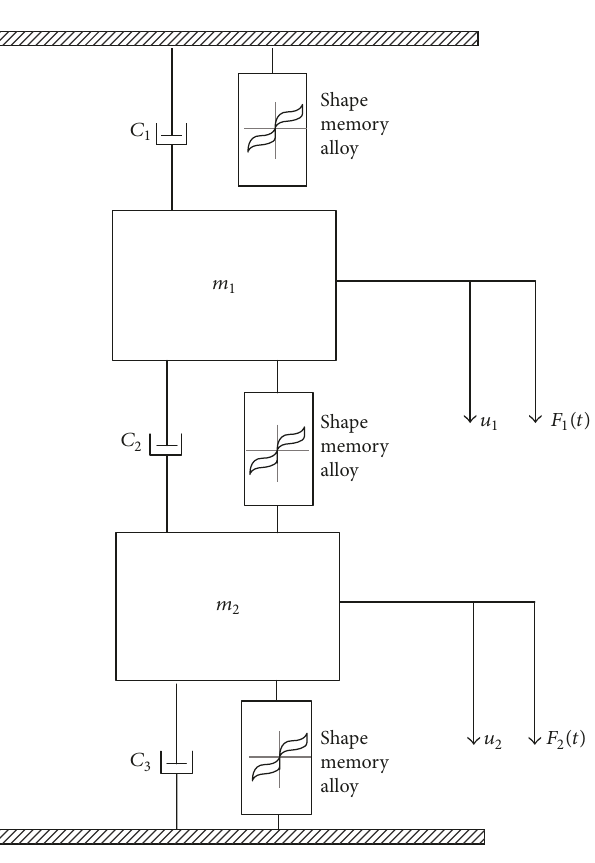
Figure 1: The two-degree-of-freedom oscillator with shape memory